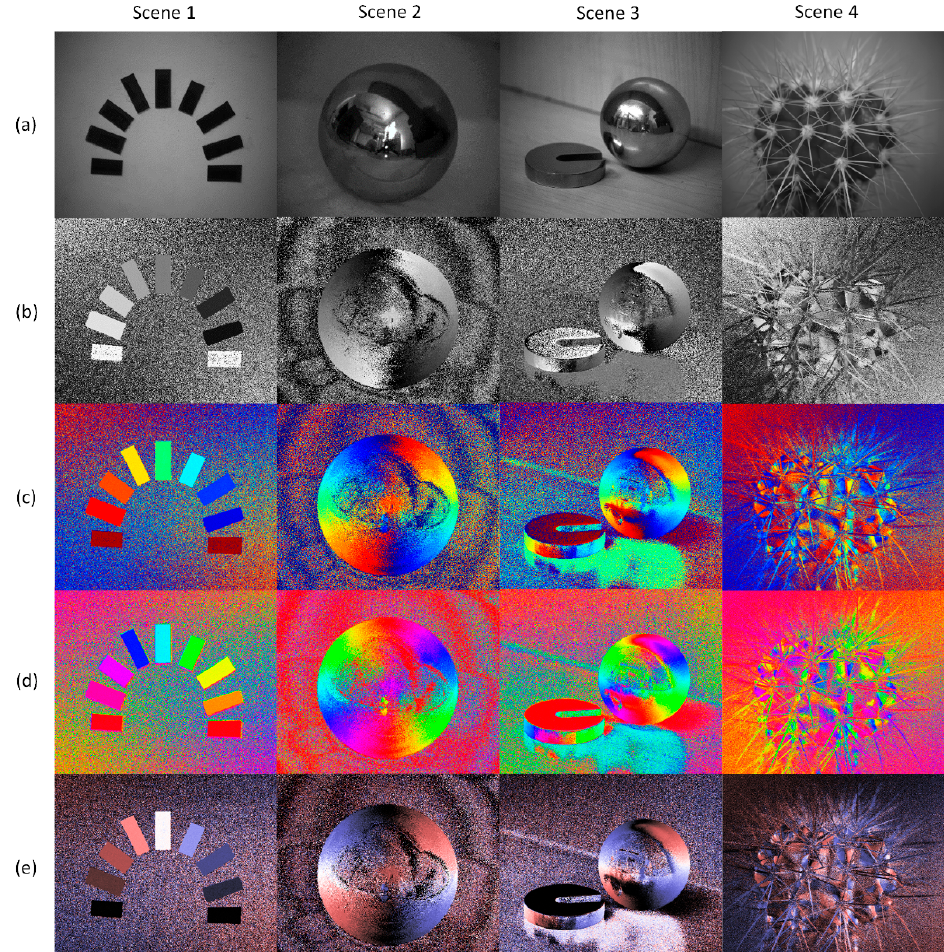
Figure 6. Experiment results for AoP visualization method. ( a ) Light intensity image; ( b ) AoP image by previous method 1; ( c ) AoP image by previous method 2; ( d ) AoP image by previous method 3; ( e )